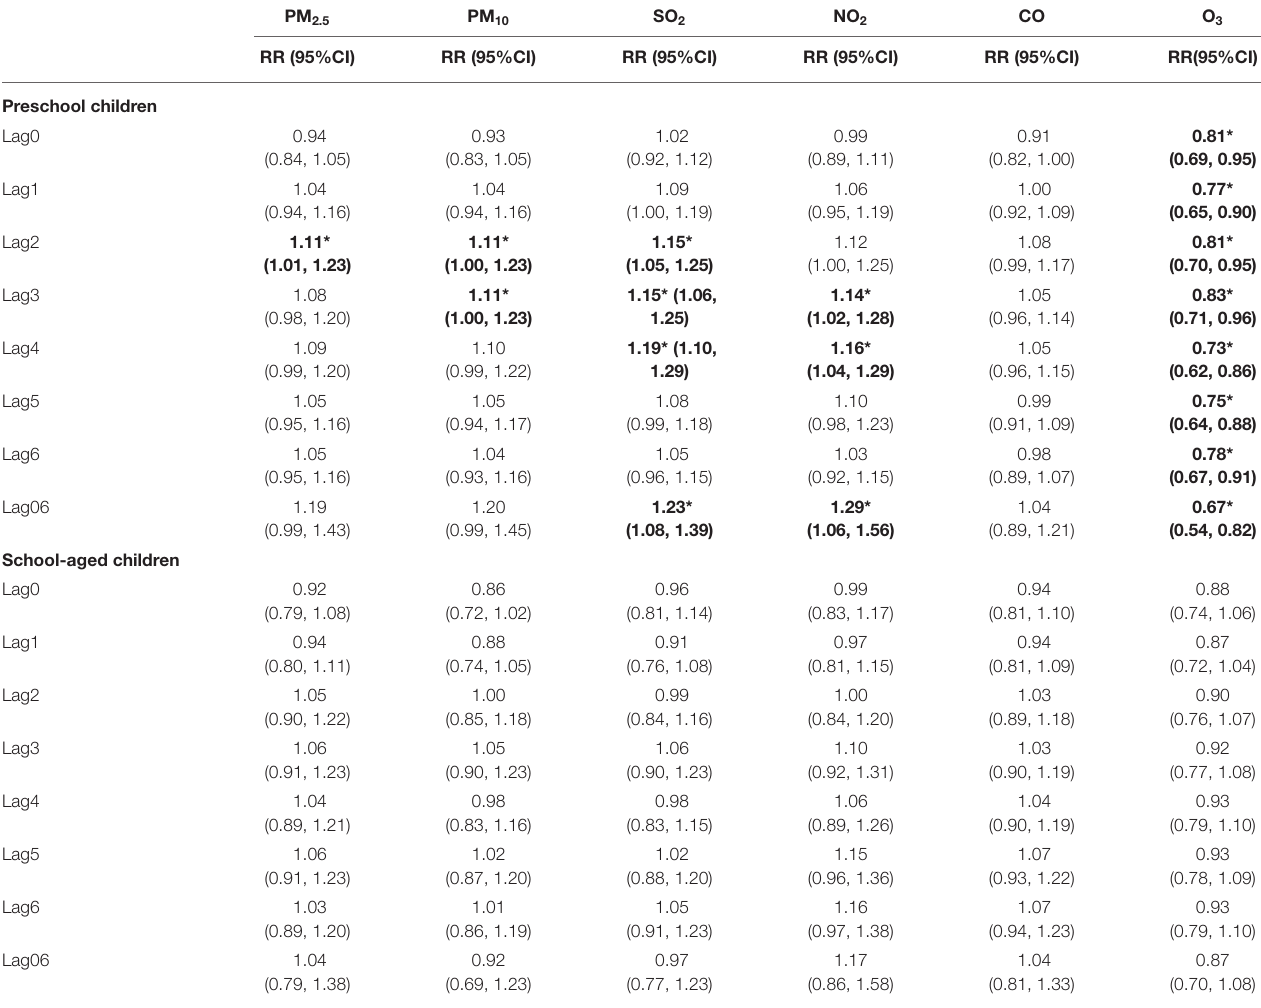
TABLE 6 | The relative risk (RR) of hospital admission for asthma in children per interquartile range (IQR) increase in different air pollutants in different lag days: single-pollutant model, stratified by age. PM 2.5 PM 10 SO